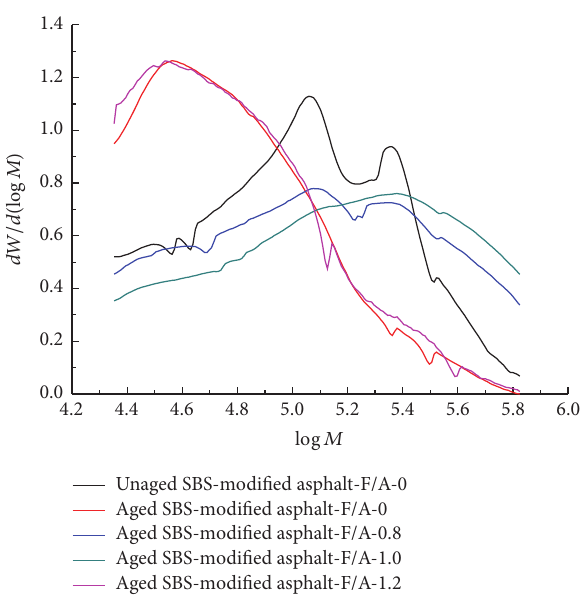
Figure 4: The molecular weight distribution of SBS modifier in modified asphalt mortar.